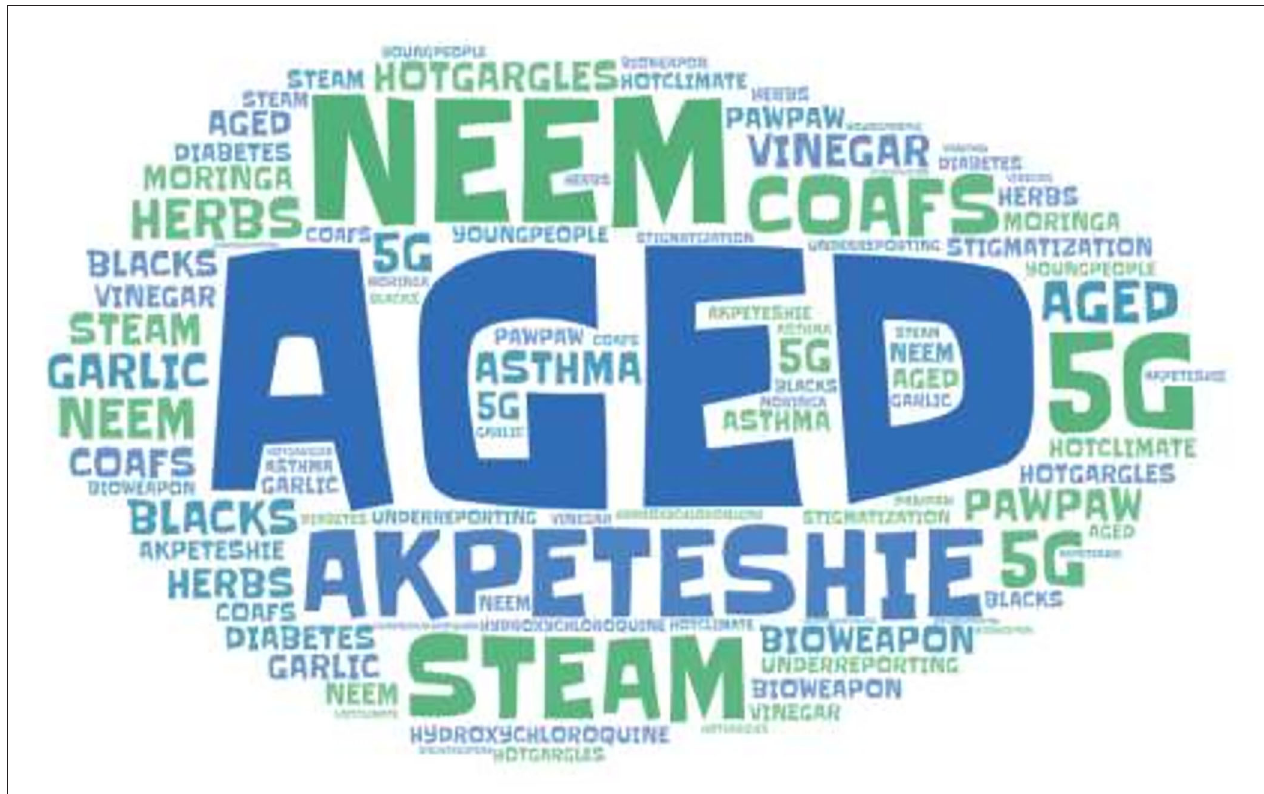
FIGURE 2 | Word cloud of COVID-19 misconceptions in Ghana,